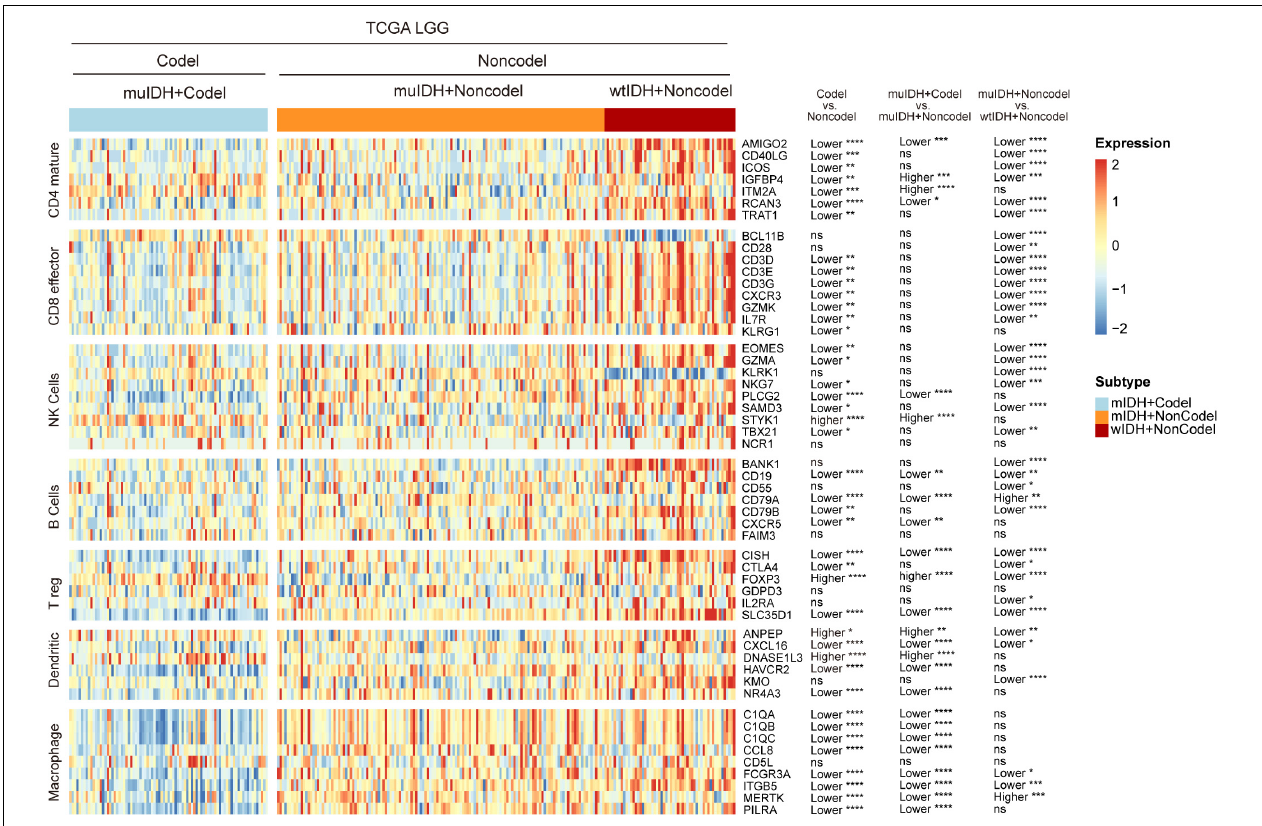
FIGURE 6 | Expression of marker genes for immune cells in TCGA LGG. The heatmap shows the expression levels of marker genes for CD4 + T cells, effector CD8 + T cells, NK cells, B cells, T-reg cells, dendritic cells, and macrophages among different subgroup LGGs in TCGA LGG. P values are inferred from a two-sided Student’s t -test or Mann-Whitney test. The number of patients in each subgroup was shown in Figure 1 . * p < 0.05, ** p < 0.01, *** p < 0.001, **** p <